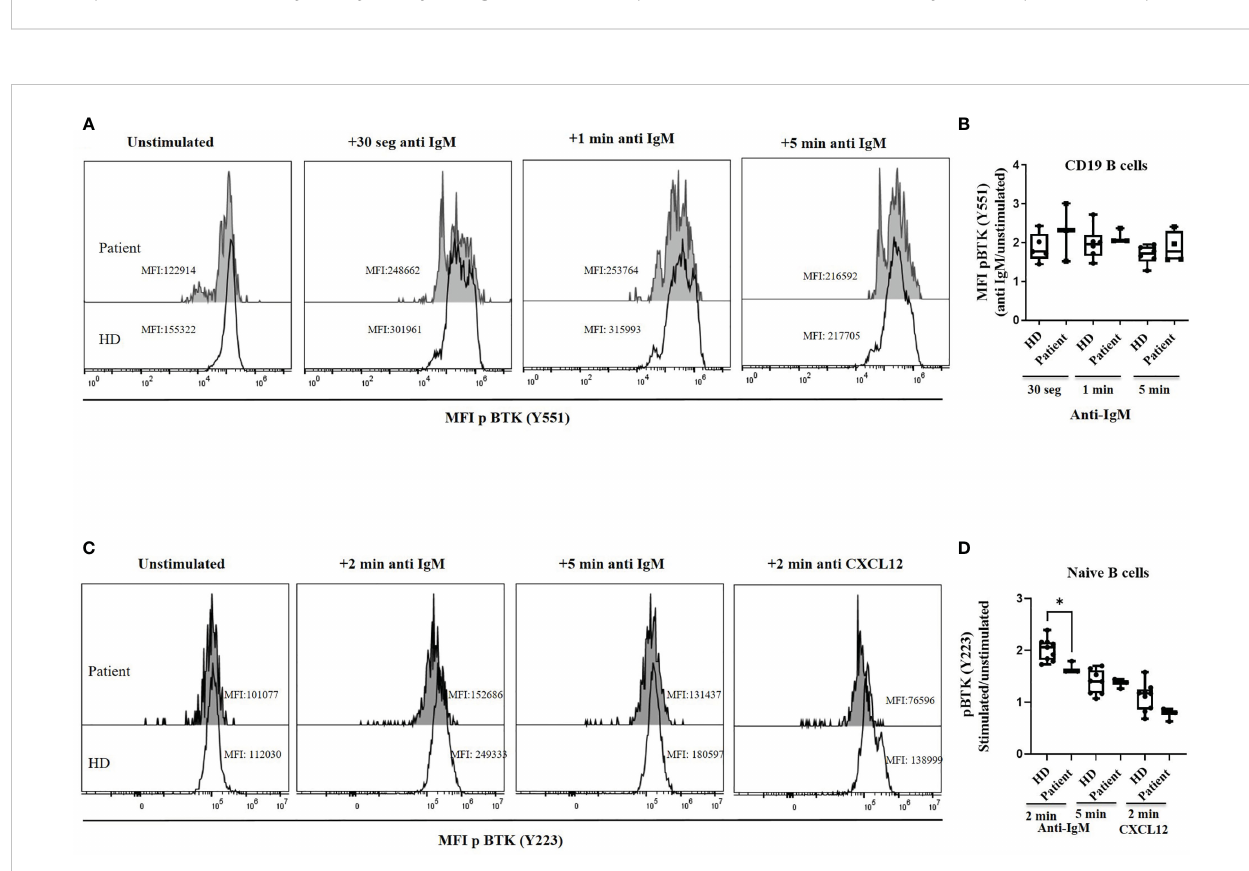
FIGURE 4 BTK phosphorylation. (A) Histograms of a representative healthy donor (HD) and patient, showing the median of mean fl uorescence intensity (MFI) of p Btk (Y551) in CD19 + B cells in unstimulated and BCR-mediated activation conditions with anti-IgM. (B) pBtk (Y551) in B cells expressed as the induced MFI at 30 s, 60 s and 5 min activation with anti-IgM compared with the unstimulated cells in B cells from HD and patient. The patient was analyzed twice in duplicates. (C) Histograms of a representative healthy donor (HD) and patient, showing median mean fl uorescence intensity (MFI) of pBtk (Y223) in naïve-B cells in unstimulated and BCR-mediated activation conditions with anti-IgM or CXCR4 activation with CXCL12. (D) pBtk (Y223) in naïve-B cells expressed as the induced MFI at 2 and 5 min activation with anti-IgM or after 2 min with CXCL12 compared with the unstimulated cells from HD and patient.